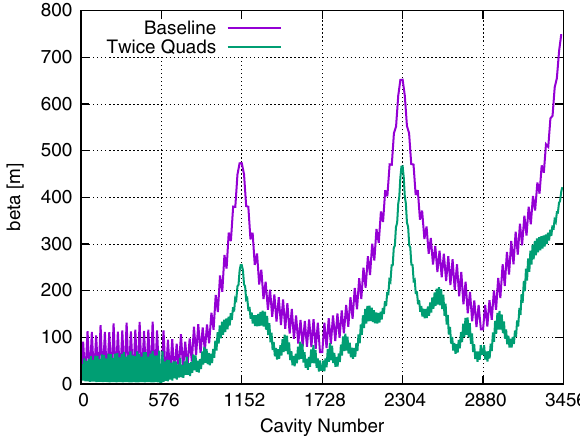
FIG. 3. Evolution of the β function during the acceleration in the newly optimized linacs. The baseline lattice with a quadrupole every two cryomodules is compared to a proposal with twice the number of